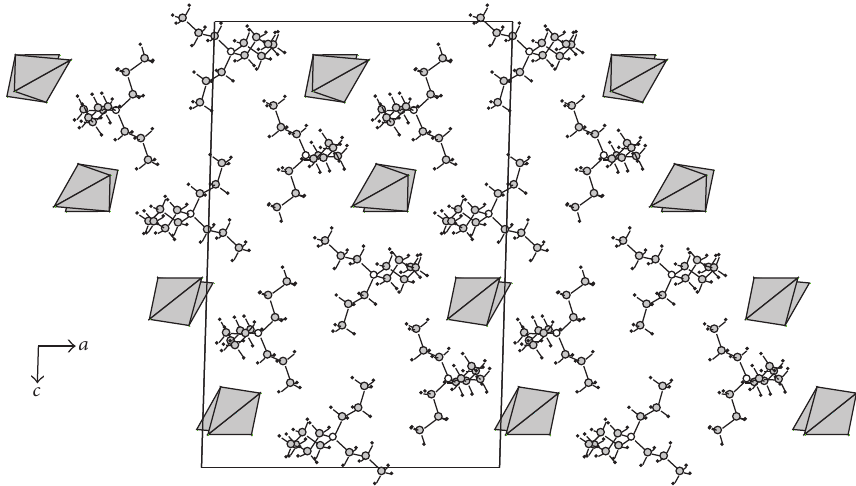
F 3: View of an organic-inorganic layer of